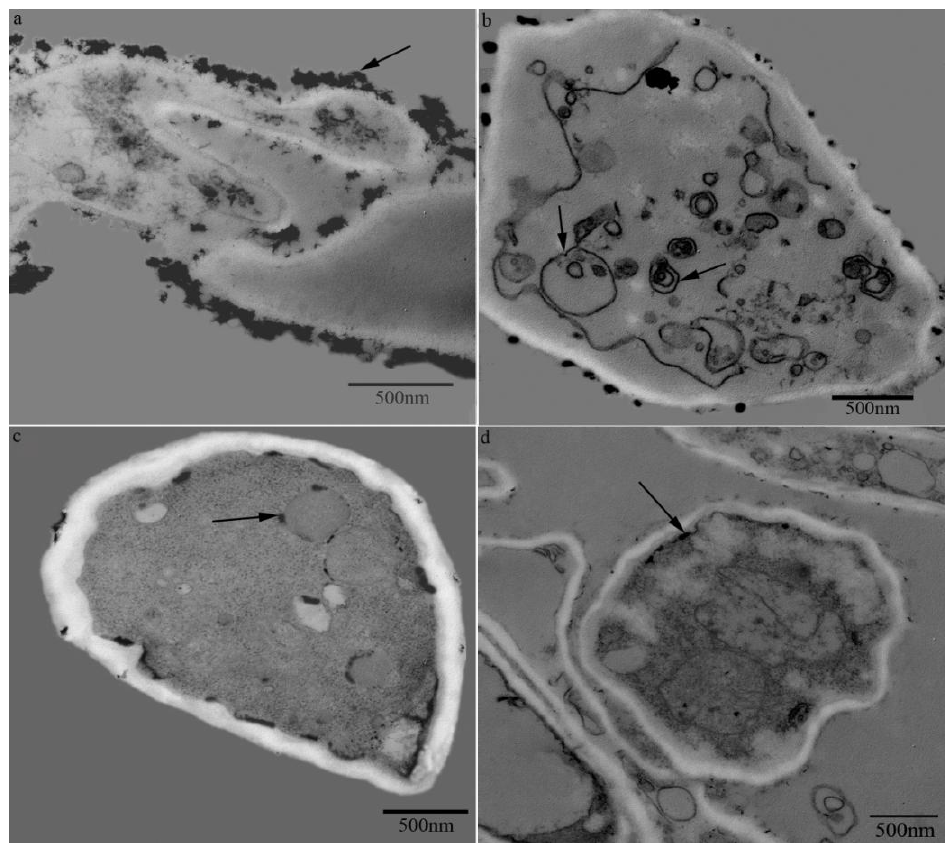
Figure 4. Cytochemical localization of H O using transmission electron microscopy 2 2 (TEM). ( a ) CeCl ( i.e. , H O production) is deposited around the cell walls (black arrow) in 3 2 2 the SD stage of sclerotial formation; ( b ) H O production is shown in the cell walls and 2 2 around the organelles such as the tonoplasts and endoplasmic reticulum membranes (black arrows) during the SM stage of sclerotial formation; ( c ) Low concentrations of H observed in the cell walls, tonoplasts and plasma membranes in the control group without sclerotial formation; ( d ) Low concentrations of H O are observed in the cell walls and 2 2 plasma membranes in the DPI treatment group. Pictures are representative of three independent experiments. Scale bar,